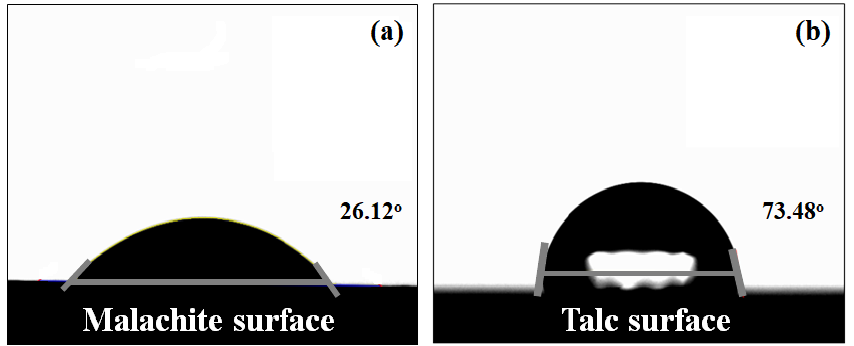
Figure 3. The hydrophobicity of malachite ( a ) and talc ( b ) surface by measuring the contact angle. The contact angles of malachite and talc are approximately 26.12° and 73.48°, respectively.